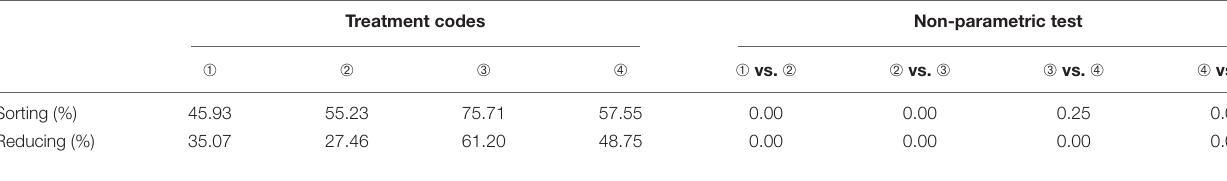
TABLE 6 | A PEB test among four different